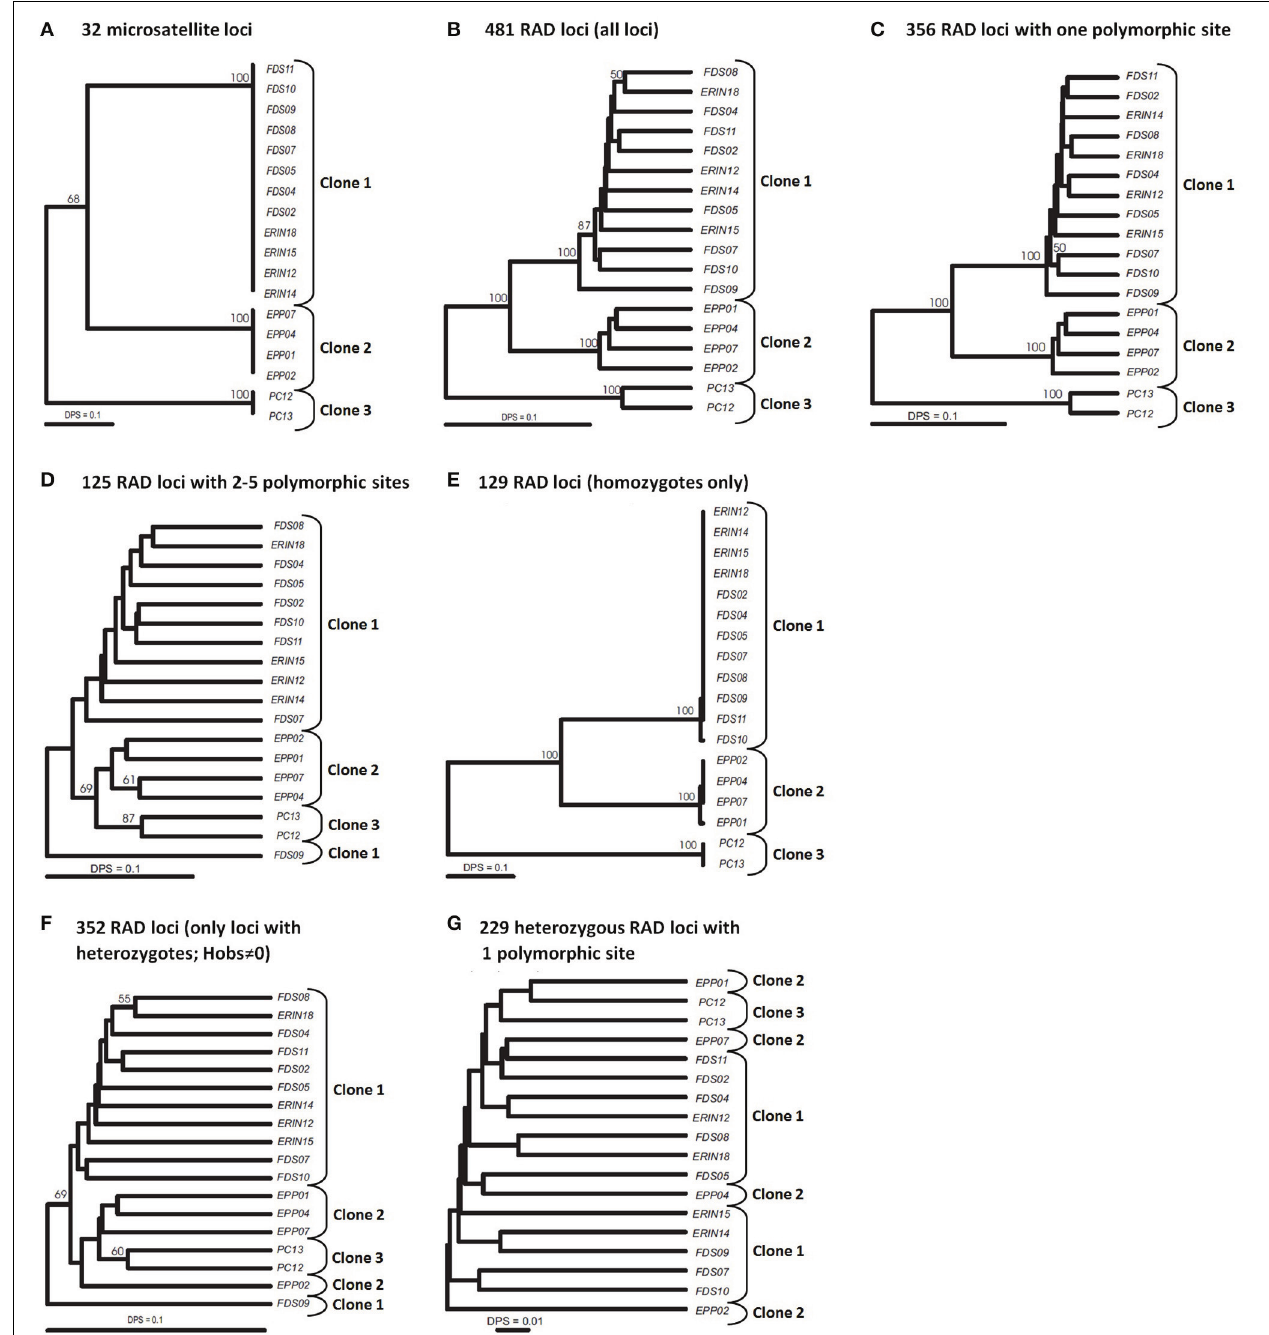
FIGURE 1 | UPGMA trees of 18 strains of mangrove rivulus. (A) Tree constructed using 32msat loci. (B–G) Trees constructed using RAD loci. (B) All 481 RAD loci. (C) 356 RAD loci containing 1 polymorphic site. (D) 125 RAD loci with 2-5 polymorphic sites. (E) 129 homozygous RAD loci (only loci